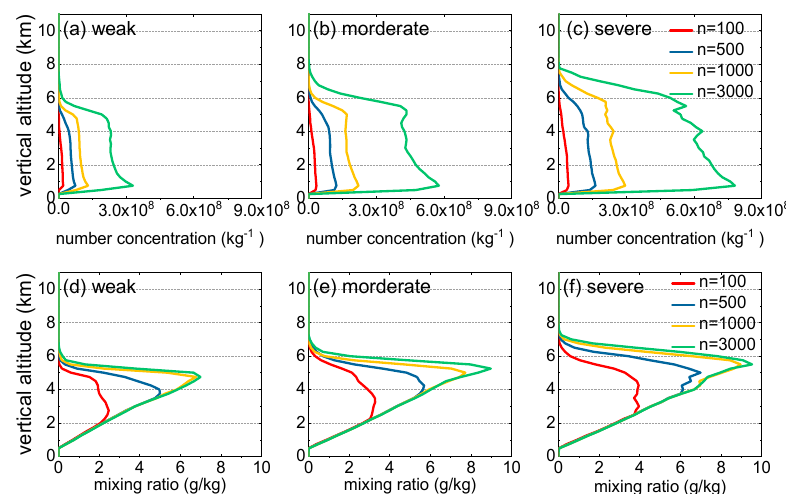
Figure 4. Vertical profiles of the maximum mixing ratio of cloud droplets in ( a ) weak thundercloud, ( b ) moderate thundercloud, ( c ) severe thundercloud; the maximum number concentration of cloud droplets in ( d ) weak thundercloud, ( e ) moderate thundercloud, ( f ) severe thundercloud; the initial aerosol concentrations are: 100 cm − 3 (red line), 500 cm − 3 (blue line), 1000 cm − 3 (yellow line), 3000 cm − 3 (green line), below is the same.